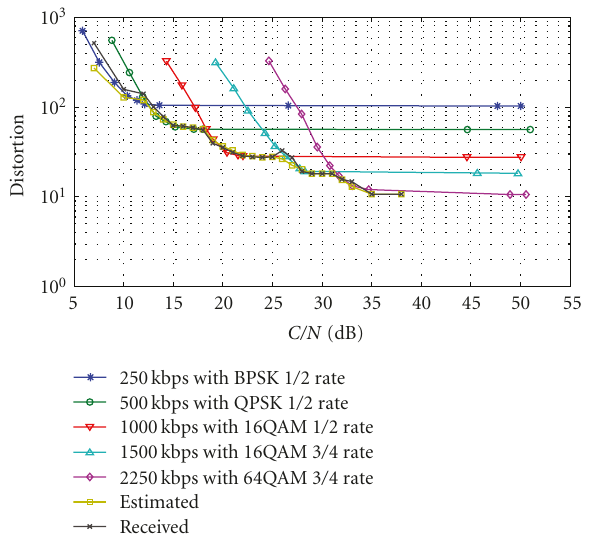
Figure 23: Distortion comparison, coastguard , GOP number 15, initial mode = 3, Set (b).